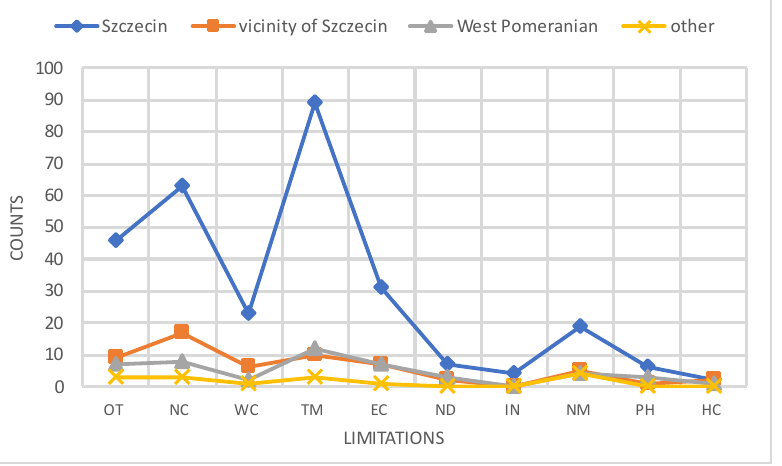
Figure 27. Graph of interactions between the limitations of bus availability and the respondent’s place of residence.